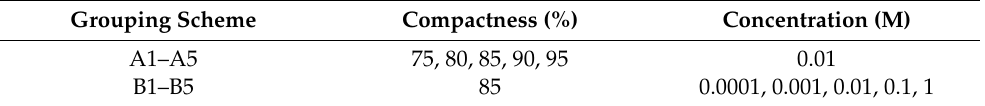
Table 1. Experimental scheme.